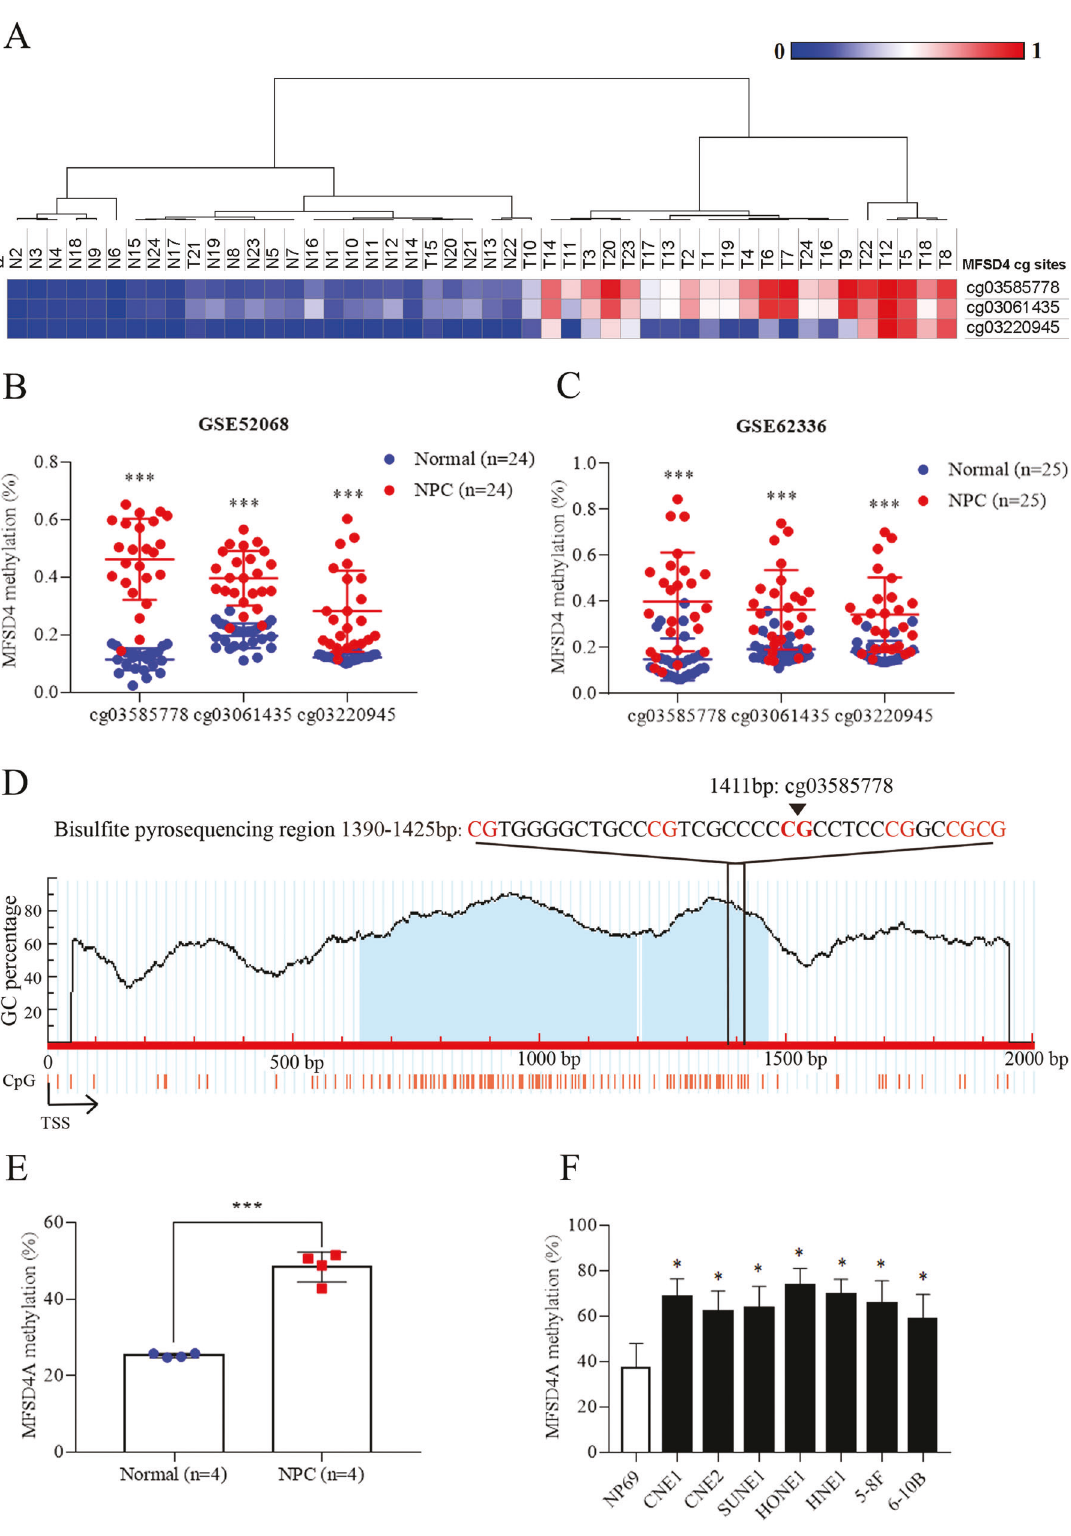
Fig. 1 MFSD4A is hypermethylated in nasopharyngeal carcinoma. A Heatmap cluster of MFSD4A CG sites between NPC ( n = 24) and normal nasopharyngeal tissue samples ( n = 24). The methylation level of MFSD4A CG sites in the GSE52068 ( B ) and GSE62336 ( C ) microarray data between NPC and normal nasopharyngeal tissue samples. D Schematic of CpG islands and bisul fi te pyrosequencing regions in the MFSD4A promoter. Red region, input sequence; Blue region, CpG islands; TSS, transcription start site; cg03585778: a CG site of MFSD4A identi fi ed in GSE52068; red text: CG sites for bisul fi te pyrosequencing; bold red text, the most methylated CG sites in MFSD4A . ( E , F ) The methylation levels of the MFSD4A promoter region de fi ned by bisul fi te pyrosequencing analysis in normal ( n = 4) and NPC ( n = 4) tissues ( E ), and in NP69 and NPC cell lines (CNE1, CNE2, SUNE1, HONE1, HNE1, 5-8 F, and 6-10B) ( F ). * P < 0.05, *** P < 0.001.